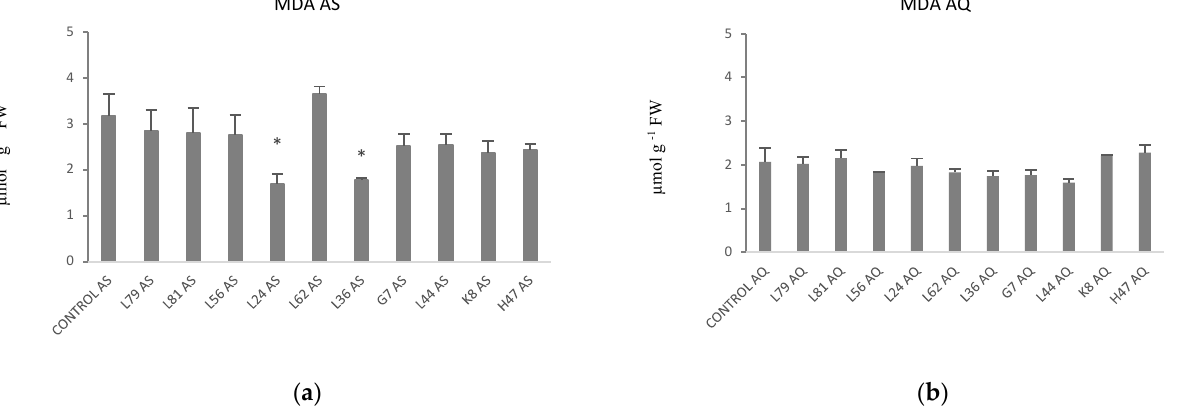
Figure 9. Malondialdehyde concentration (µmol g − 1 FW), in ( a ) AS and ( b ) AQ leaves of plants inoculated with the 10 PGPB and non-inoculated controls. Values are the average ± SE (n = 3). As- terisks (*) indicate significant differences with the controls according to t student ( p < 0.05).